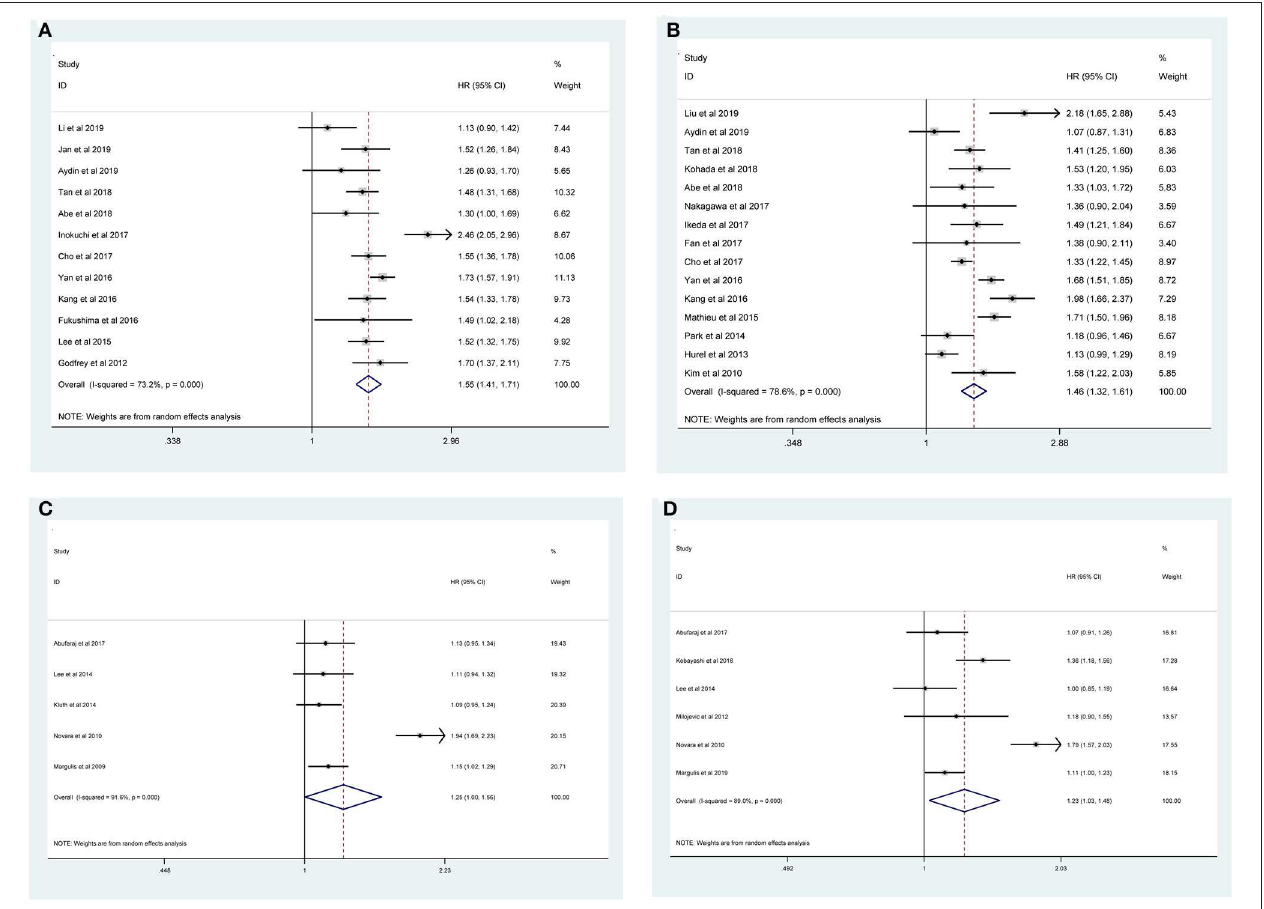
FIGURE 3 | Forest plots assessing the correlation of LVI and (A) OS, (B) RFS, (C) CSM, and (D) recurrence in studies considering patients with UTUC.